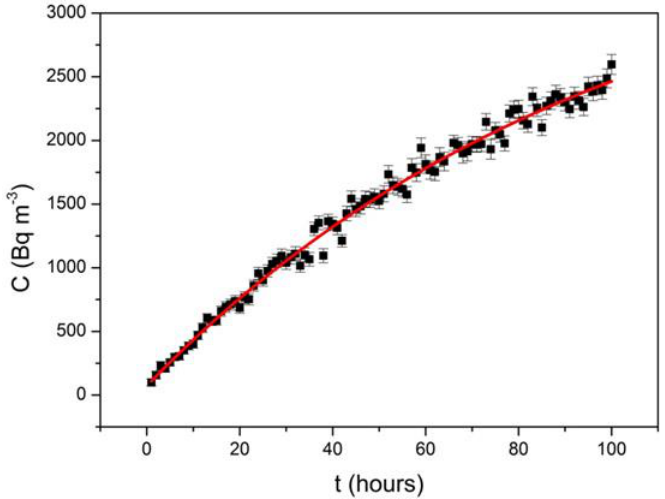
Figure 5 . Build − up of radon in accumulation chamber. Exponential adjustment done according to Figure 5. Build-up of radon in accumulation chamber. Exponential adjustment done according to Equation (1). Equation